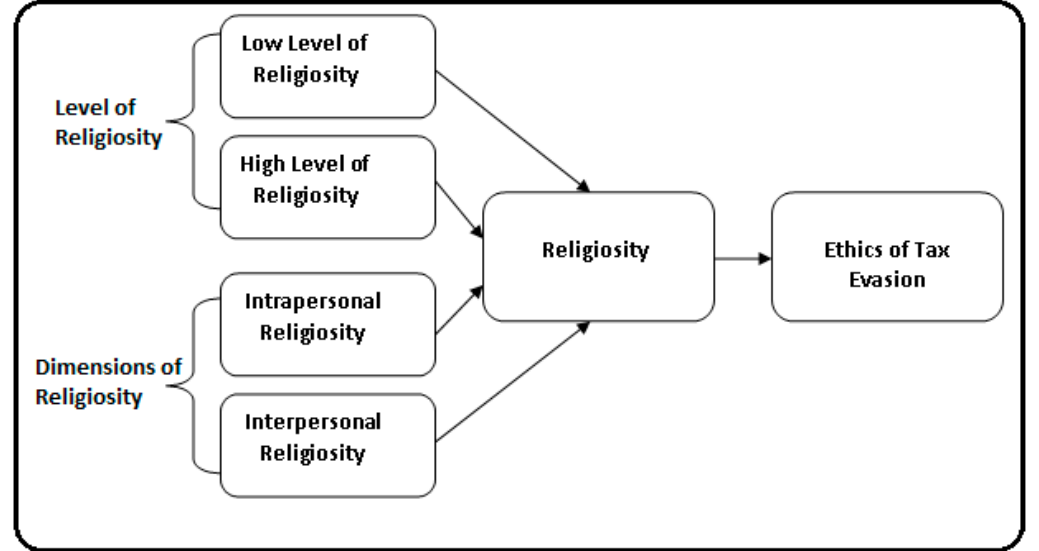
Figure 1. Research framework for the study.